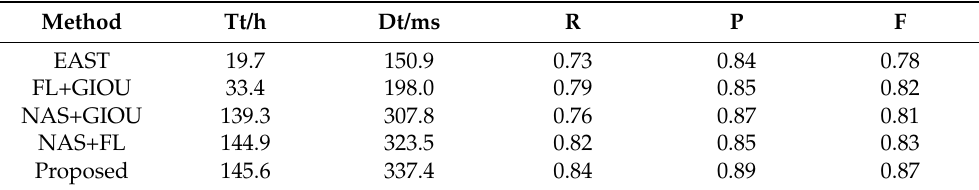
Figure 14. Impact of NAS-FPN on text detection. Impact of ( a ) search algorithm and ( b ) backbone network on model performance. Table 4. Experimental results for various